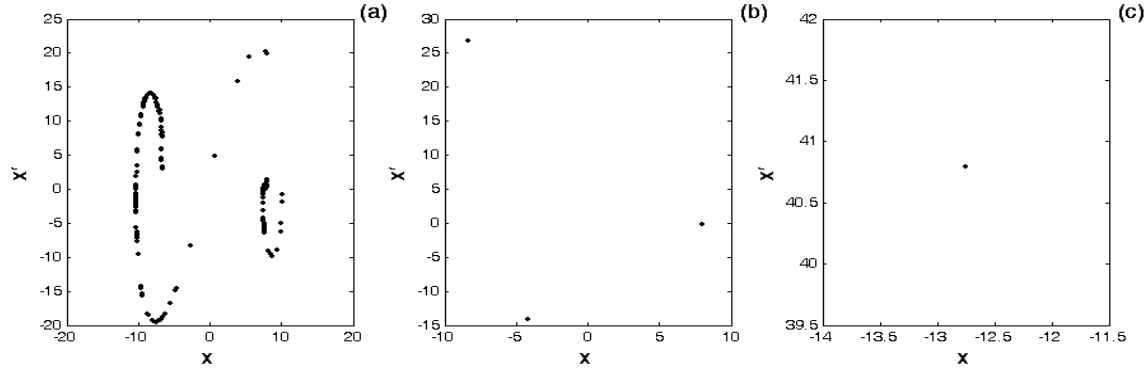
Fig. 10. Poincare maps on the responses of coupling system with different squeeze film damping ratio: (a) β = 0 . 04 ; (b) β = 0 . 1 ; (c) β = 0 . 2 .